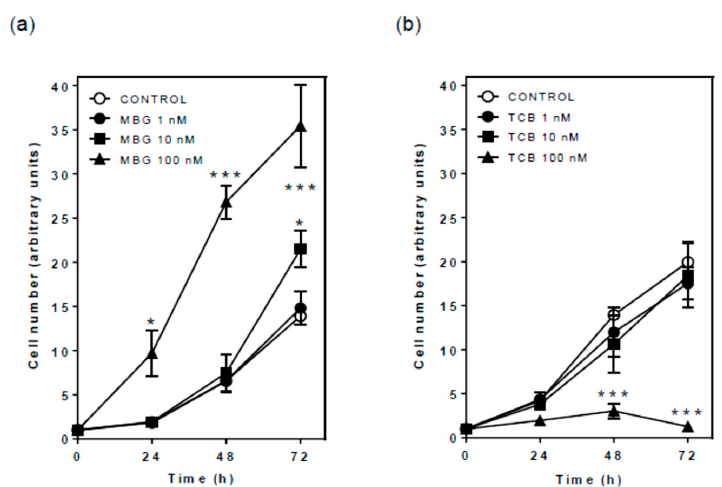
Figure 3. Cell proliferation of LLC-PK1 cells treated with marinobufagin (MBG) or telocinobufagin (TCB). Serum-starved LLC-PK1 cells were treated with 1, 10, and 100 nM MBG ( a ) or TCB ( b ) in 2.5% FBS for 24, 48, and 72 h, and then Trypan blue-free viable cells were counted in Neubauer chamber. Each point represents the mean ± SEM of three independent experiments performed in duplicate. * p < 0.05; *** p < 0.005 vs. control.